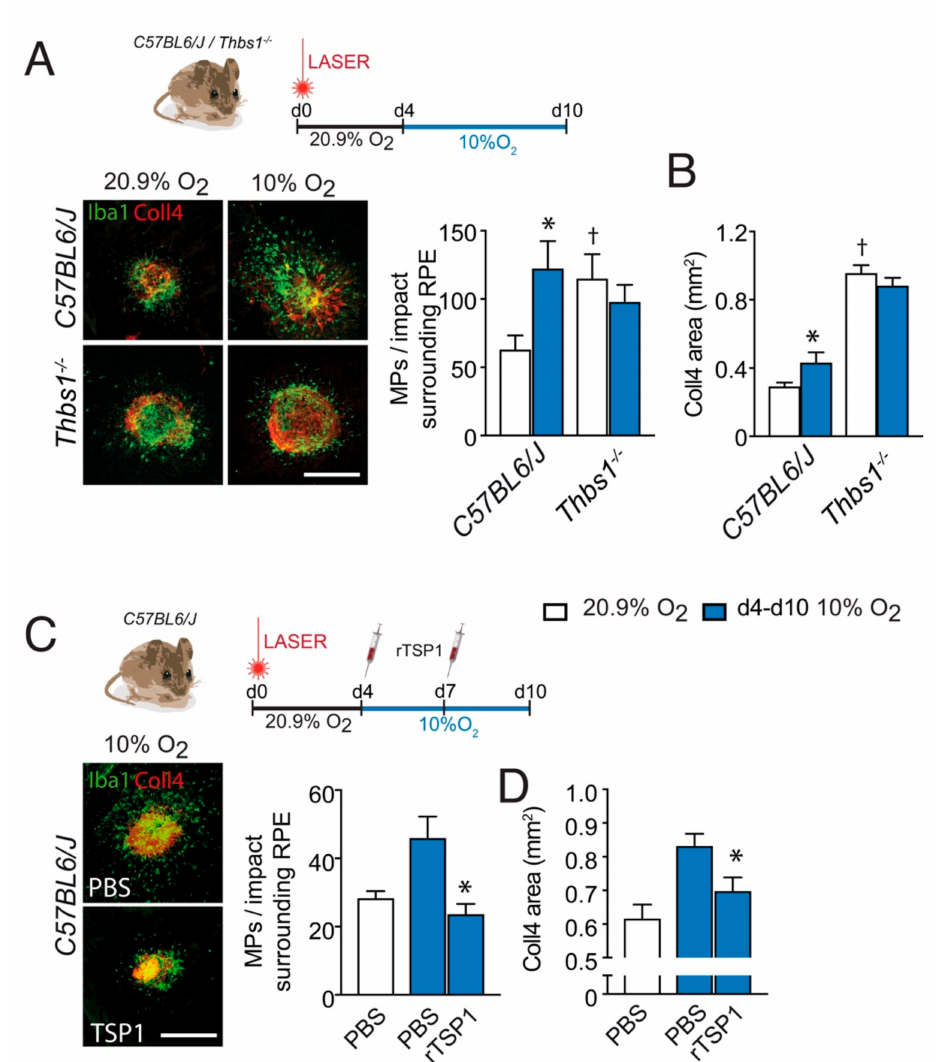
Figure 3. TSP-1 is necessary for hypoxia-induced inhibition of inflammation resolution after laser- injury. ( A ) Representative images of Collagen 4 (Coll4; red) and IBA-1 (green) immuno-stained RPE/choroid flatmounts of 10 day post laser-injured 2-month-old mice of the indicated strains, raised in 20.9% ambient O 2 (normoxia, white columns) or exposed to 10% O 2 hypoxia (d4–d10, blue columns) and quantification of subretinal IBA-1 + MPs per impact on the RPE counted at a distance of 0–500 µ m to Coll4 + CNV of the indicated strains ( n = 9–10 eyes; * p = 0.0002; † p = 0.0114; Mann– Whitney versus the normoxic C57BL6/J mice, hypoxic Thbs1 − / − mice were not significantly different from hypoxic C57BL6/J mice). (B) Quantification of the Coll4 + CNV surface at d10 of normoxic and hypoxia-exposed (d4–d10) laser-injured mice of the indicated strains ( n = 9–10 eyes; * p < 0.0001; † p = 0.0114; Mann–Whitney versus the normoxic C57BL6/J mice). (C) Representative images of Coll4 (red) and IBA-1 (green) immuno- stained RPE/choroid flatmounts of 10 day post laser-injured, 2 month-old, wildtype mice exposed to 10% O 2 hypoxia (d4–d10) that were intravitreally injected at d4 and d7 with 2 µ L of PBS, or 2 µ L of PBS containing recombinant Thrombospondin 1 protein (TSP-1, 10 µ g/mL) and the quantification of subretinal IBA-1 + MPs per impact on the RPE counted at a distance of 0–500 µ m to Coll4 + CNV at d10 ( n = 9–10 eyes; * p = 0.0001; versus the hypoxic PBS-treated mice). (D) CNV surface at d10 of the treated, hypoxia-exposed (d4–d10), laser-injured mice ( n = 9–10 eyes; * p = 0.00143; Mann–Whitney versus the hypoxic PBS-treated mice). All values are reported as mean ± SEM. PBS: Phosphate buffered saline; rTSP-1: Recombinant thrombospondin 1; scale bar = 400 µ